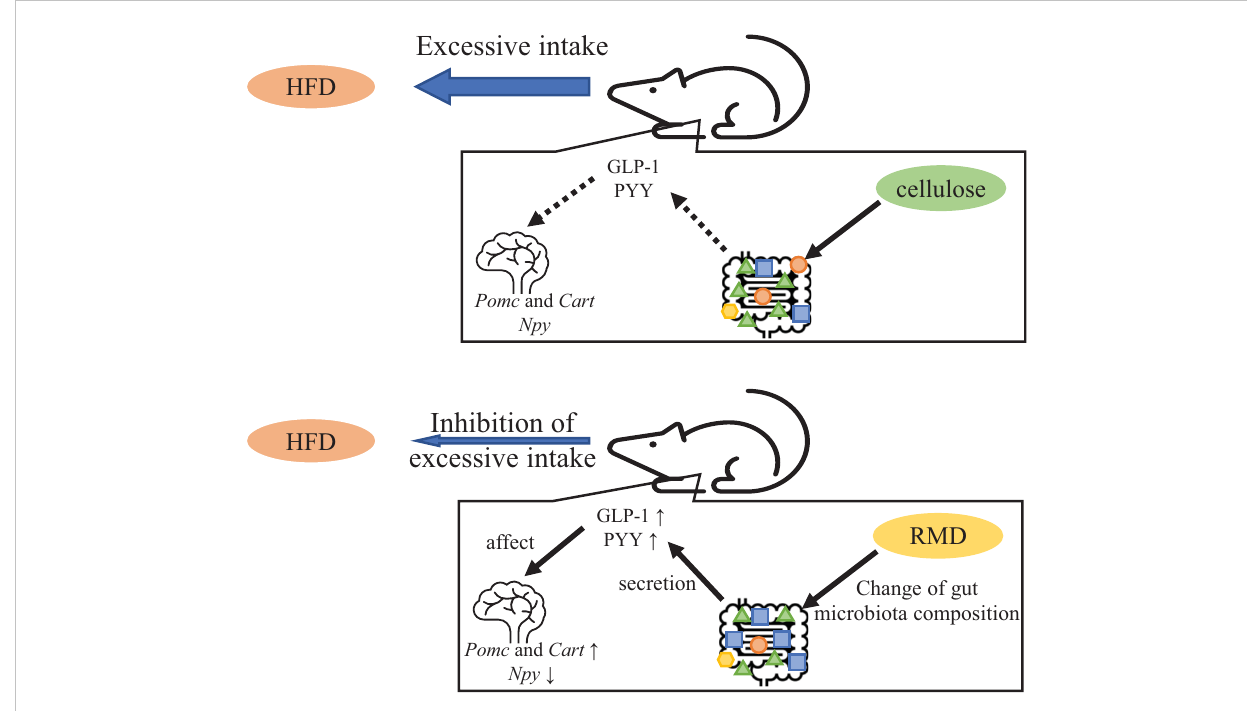
FIGURE 10 Predicted mechanism of appetite suppression and